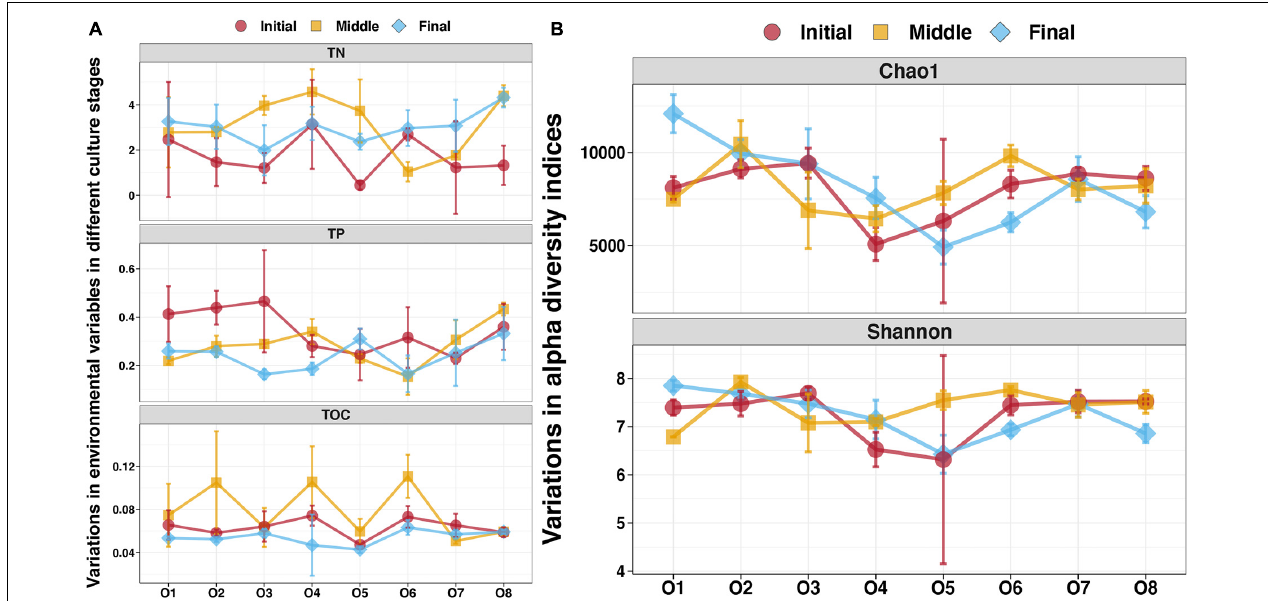
FIGURE 1 | (A) Sediment characteristics at different locations in the purification area of the IPRS during the culture cycle. (B) Alpha diversity indices of the benthic bacterial communities at different locations in the purification area of the IPRS during the culture cycle.